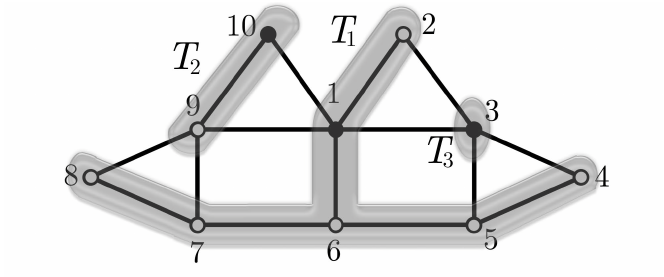
Fig. 1. The forcing trees in a graph